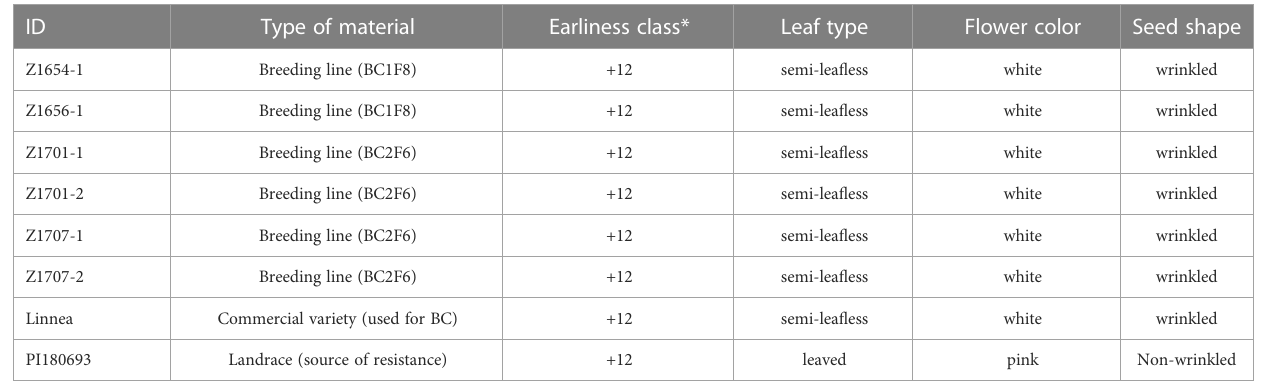
TABLE 1 Information about pea cultivars used in the